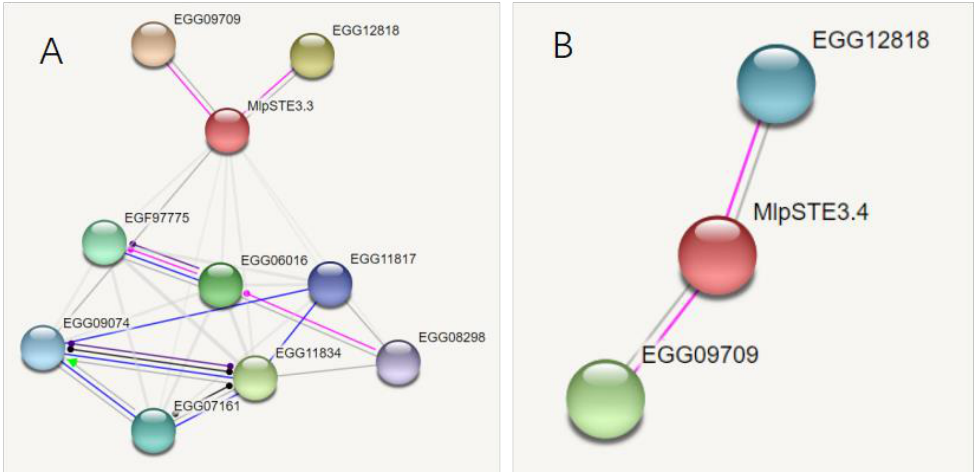
Figure 3. Functional prediction of STE3.3 and STE3.4 protein. Pink lines indicate posttranslational modification, dark blue lines indicate binding, and black lines indicate reaction. ( A ) STE3.3; ( B ) STE3.4